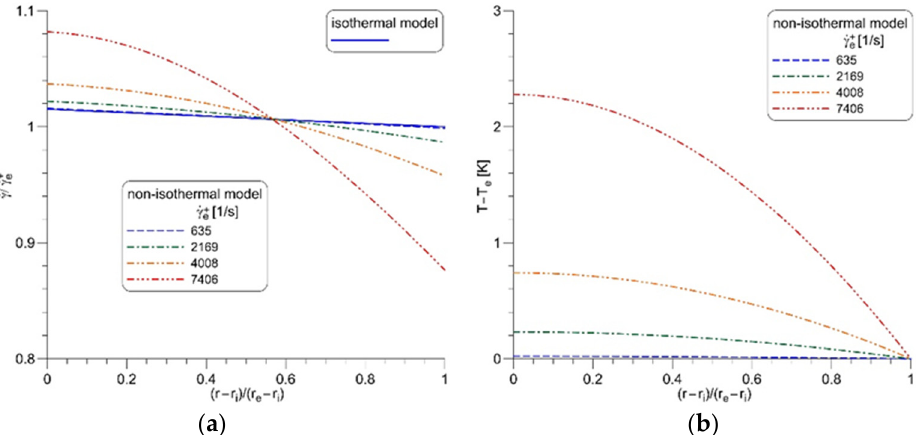
Figure 3. Comparison of isothermal and non-isothermal flow in the measuring gap for the base oil 10W40 at cup temperature − 10 °C: ( a ) the dimensionless shear rate, ( b ) the oil temperature rise. 10W40 at cup temperature − 10 ◦ C: ( a ) the dimensionless shear rate, ( b ) the oil temperature